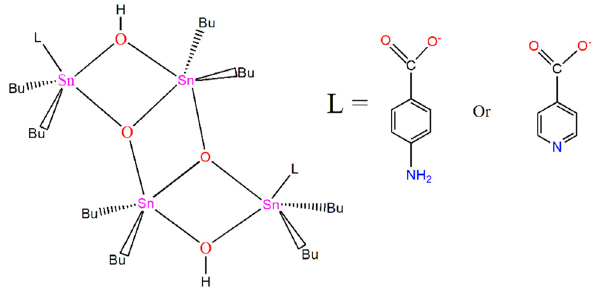
Figure 1: Tetranuclear structure of [ C 5 H 4 N -( p - CO 2 )] 2 [ Bu 2 Sn ] 4 ( μ 3 - O ) 2 ( μ - OH ) ( 1 ) 2 2